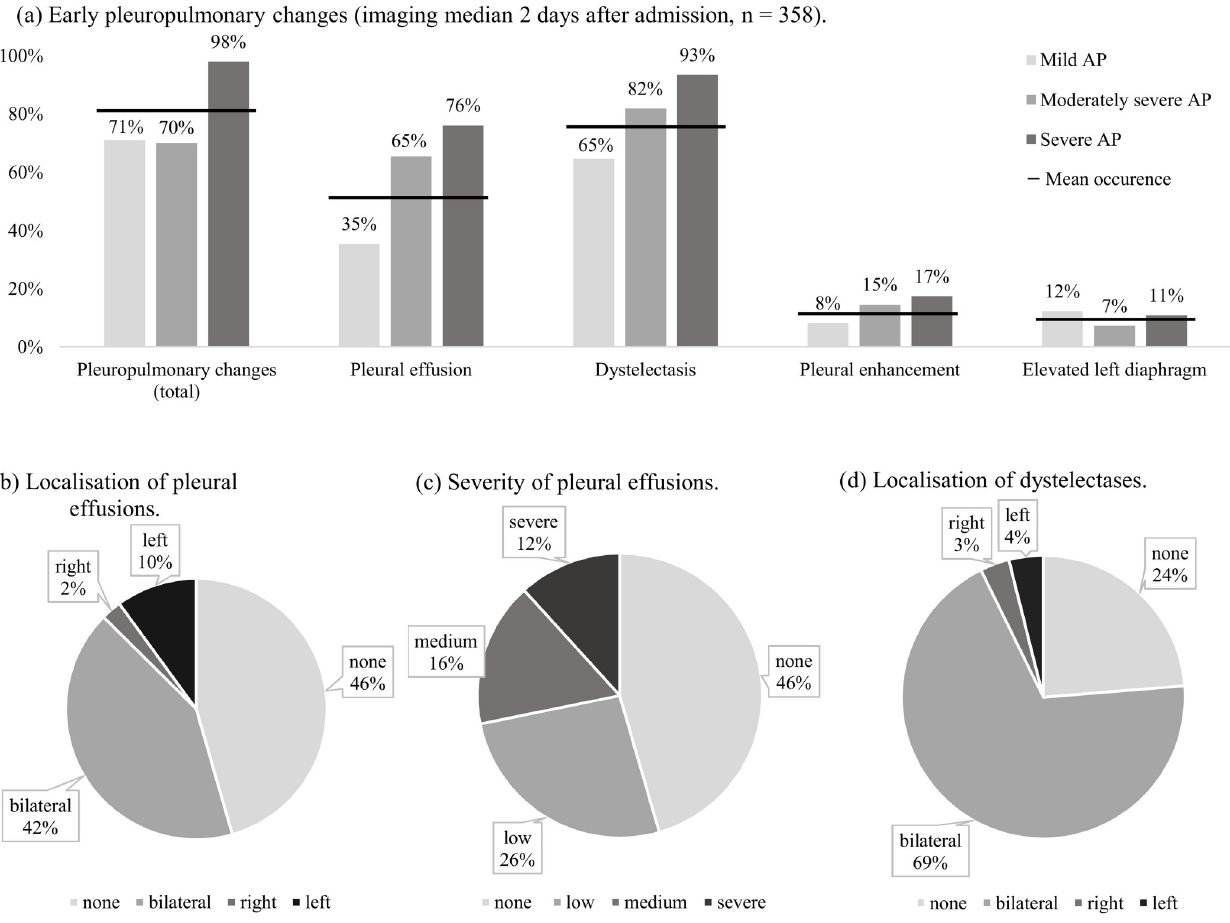
Fig 2. Distribution of early pleuropulmonary findings in CECT imaging from patients with acute pancreatitis (n = 358). Proportions of all pleuropulmonary findings in the study population with subdivisions into the different grades of acute pancreatitis (AP) are depicted in (a). The median timing of CECT imaging was 2 days after admission. Graphs (b) and (c) show the detailed localisation and severity of pleural effusions (PEs) and (d) the distribution of dystelectases. In total, 81% (289/358) of patients had pleuropulmonary changes in CECT imaging and the occurrence mostly increased with severity of AP, e.g. approximately one-third of patients with mild AP showed PEs (52/147, 35%), whereas PEs appeared in 76% (35/46) in patients with severe AP. In most cases (273/358, 76%) the detected findings were dystelectases. More than 90% (247/273, 91%) of dystelectases appeared bilateral. Pleural enhancement was found in 12% (44/358) and an elevation of the left diaphragm in 10% (35/358). More than half of the patients had PE (195/358, 54%), that was mostly (150/195, 77%) bilateral. If unilateral, PE was observed particularly in the left pleural cavity (36/45, 80%). When PE was prevalent, its amount was classified as low, moderate or severe in 48% (94/195), 30% (59/195) and 22% (42/195) of the cases,